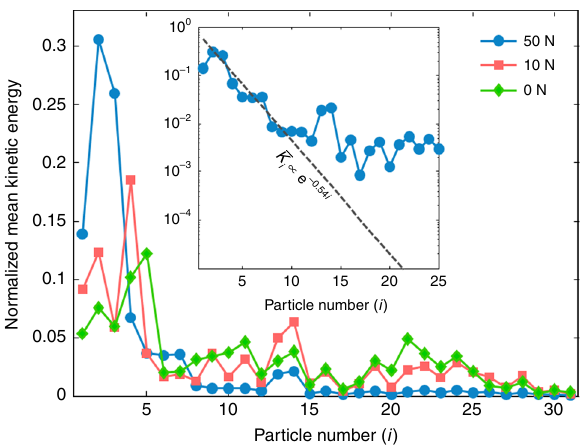
Fig. 3 Experimental observation of Anderson-like localization. Normalized kinetic-energy pro fi le, averaged between 1.5 and 3.5 ms, for different amounts of precompression. In the inset, we show the kinetic energy on a logarithmic scale when the static precompression is 50 N. The dashed line shows the slope associated with e − 0.54 i , where i denotes particle dynamical regimes of the chain. To visualize the propagation of stress waves in each case, we show spatiotemporal distributions of the particles ’ motions based on the measured velocity. In Fig. 2, we show experimental measurements of particle velocities for a homogeneous chain consisting of (top row) aluminum particles only and (bottom row) a disordered chain composed of aluminum and tungsten-carbide particles in strongly nonlinear, weakly nonlinear, and almost linear scenarios (left, middle, and right, respectively). See Supplementary Fig. 1 and Supplementary Note 2 for details of how we characterize nonlinearity strength.